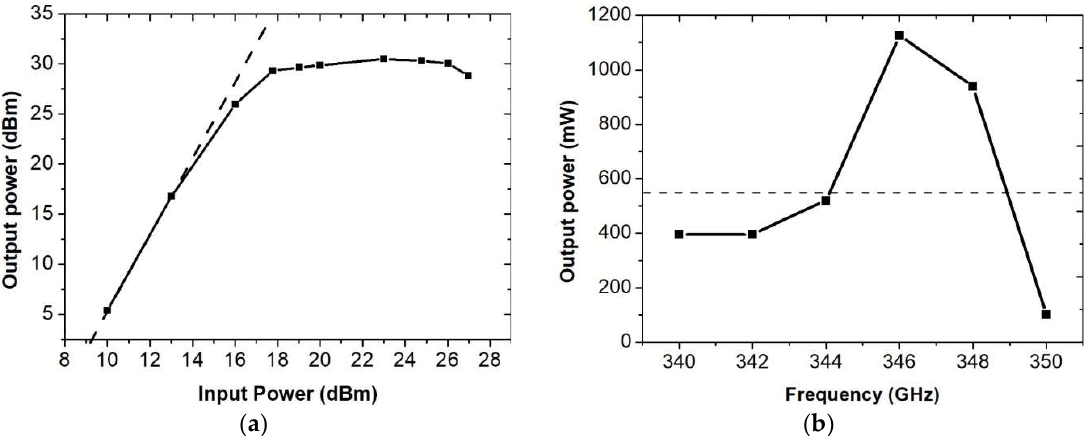
Figure 16. gain property ( a ) and bandwidth property ( b ) of CE-HHTWT. Figure 16. Gain property ( a ) and bandwidth property ( b ) of